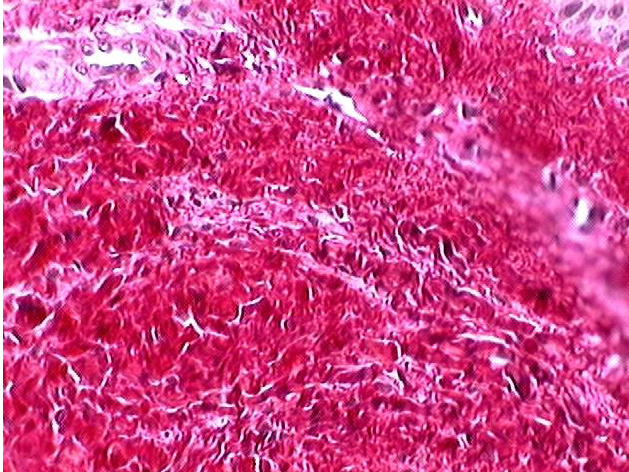
FIGURE 5 – Sample slide stained by picrosirius red demonstrating lamina proprias´ connective tissue before